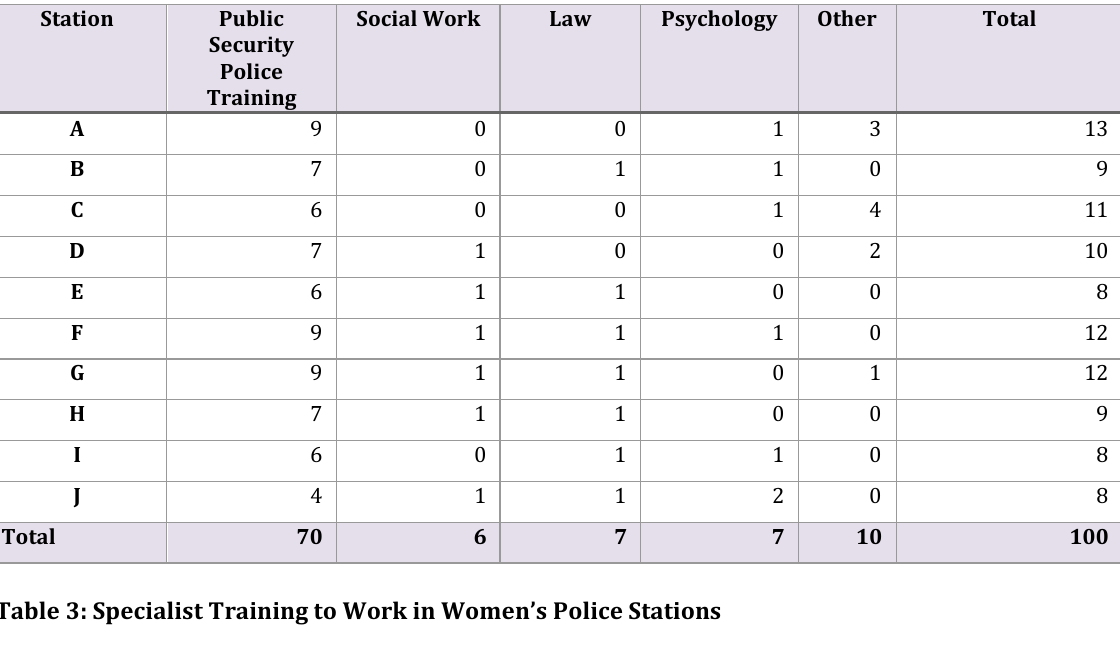
Table 2: Professional Qualifications